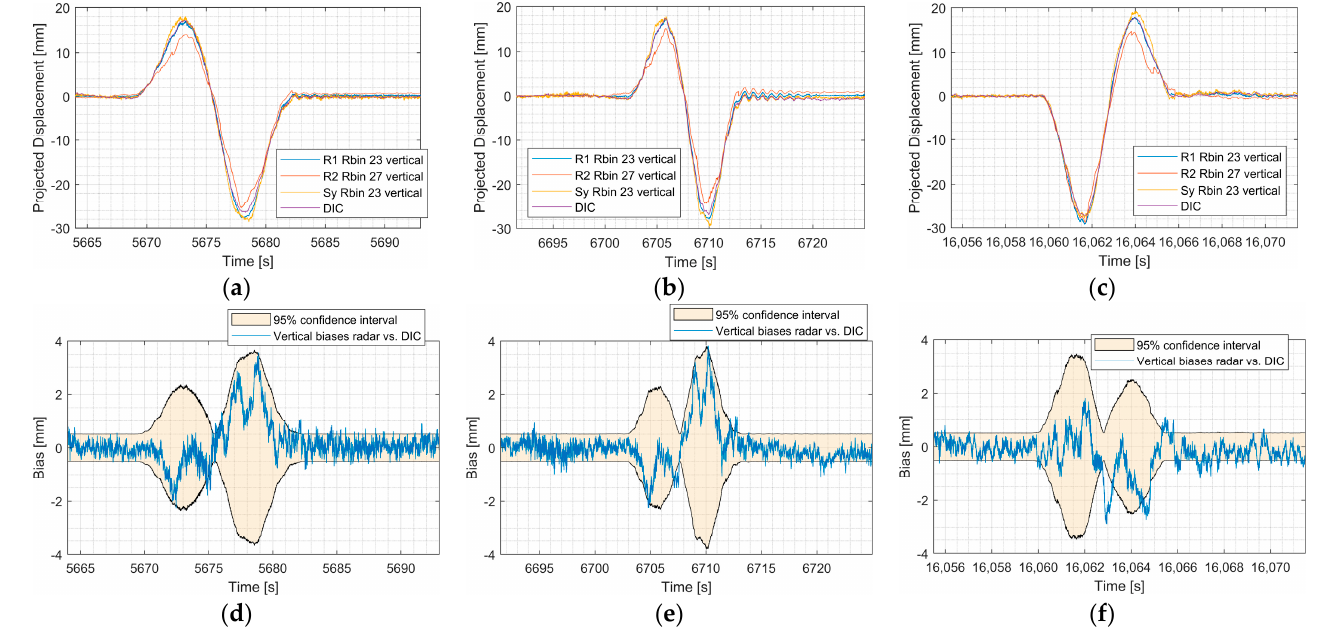
Figure 28. First row: comparison of vertical displacements during the passage of the test train including 2 locomotives: ( a ) at 40 km/h—direction Bratislava; ( b ) at 50 km/h—direction Bratislava; ( c ) at 90 km/h—direction Žilina; second row: comparison of the confidence intervals with biases between radar and DIC measurement of vertical displacements: ( d ) for the train speed 40 km/h. Percentage of the biases that belong into the 95% confidence interval is 96%; ( e ) 50 km/h, 94%; ( f ) 90 km/h, 84%.